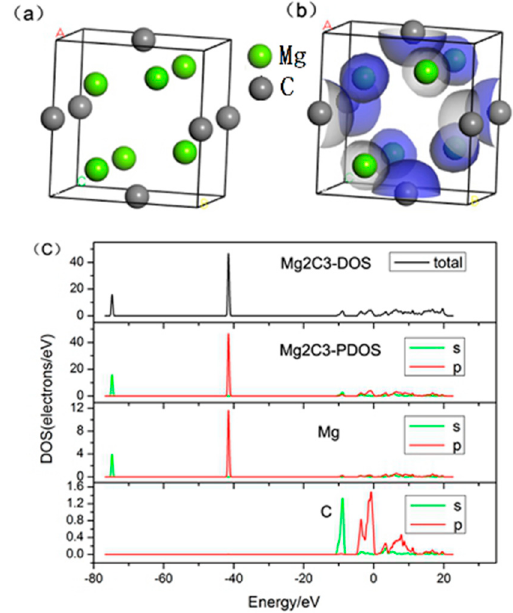
Figure 6. First-principle study of Mg 2 C 3 : ( a ) unit cell model, ( b ) electron density map, and ( c ) state density maps.